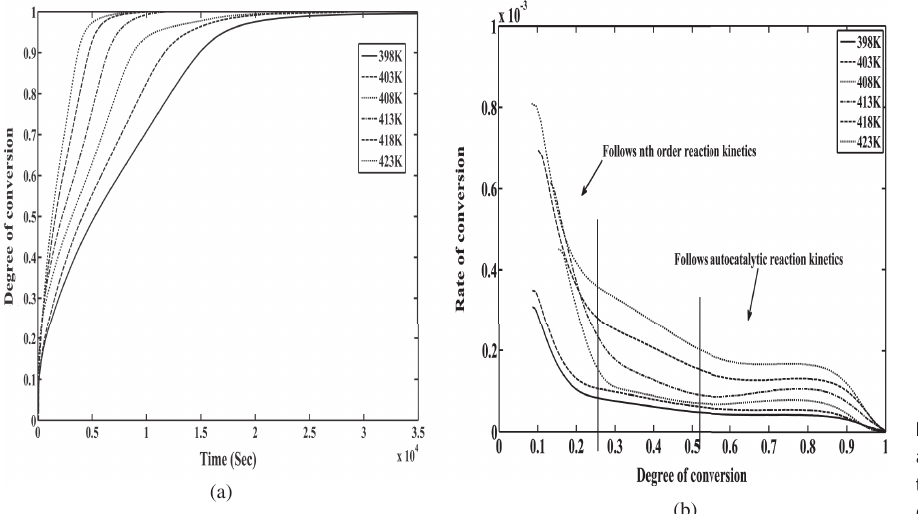
Figure 7: (a) Degree of conversion and (b) rate of conversion in iso- thermal curing process at differ- ent temperatures.